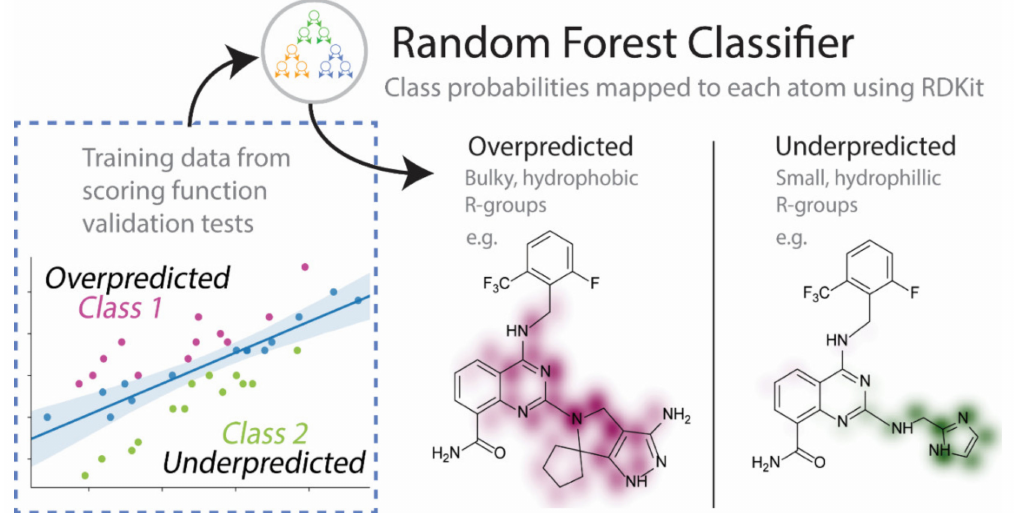
Figure 9. An overview of the machine learning approach used to systematically diagnose molecular features that were correlated with poor scoring accuracy. Example molecules where the scoring function performed poorly (i.e., instances where the error was larger than the 95% confidence interval) were labeled. A random forest classifier was trained on the bit vector of the Morgan fingerprint of the ligand to identify features of the ligands that may contribute to over- or underpredictions by the soring